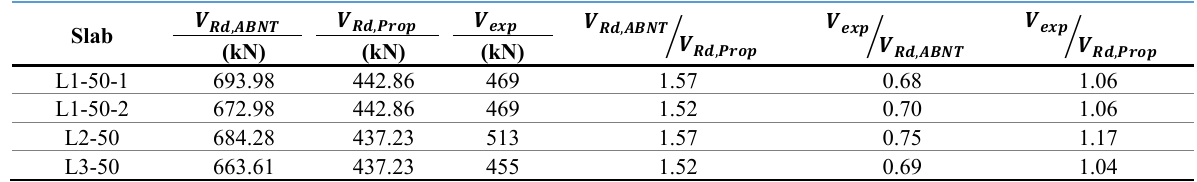
Table 10. Comparison Experimental, ABNT NBR 16935 (2021) [12] and Proposed Model